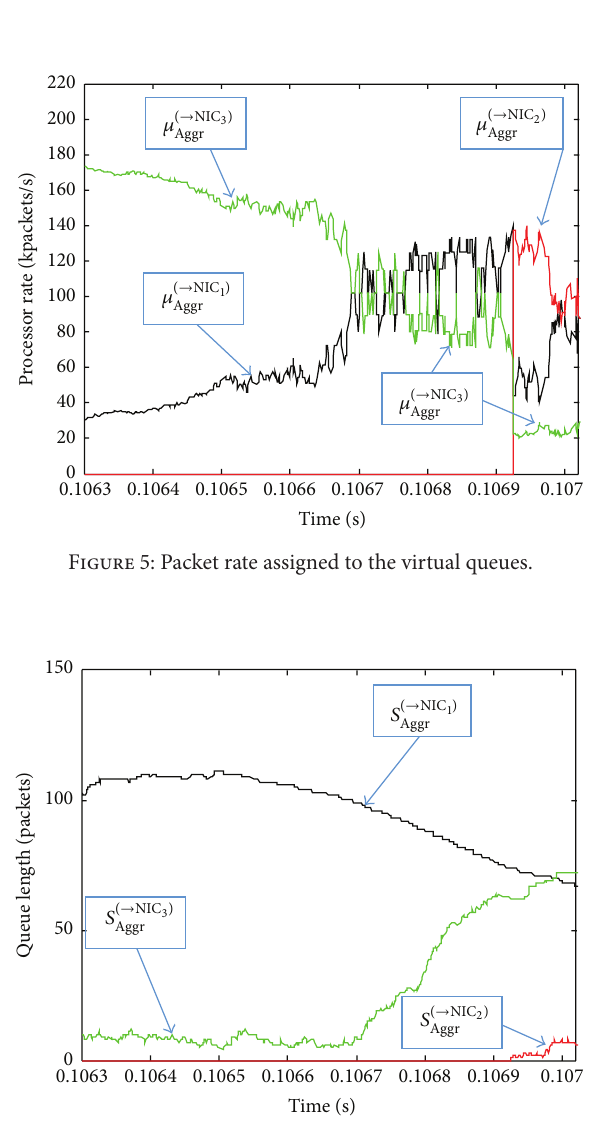
Figure 6: Lenght evolution of the virtual